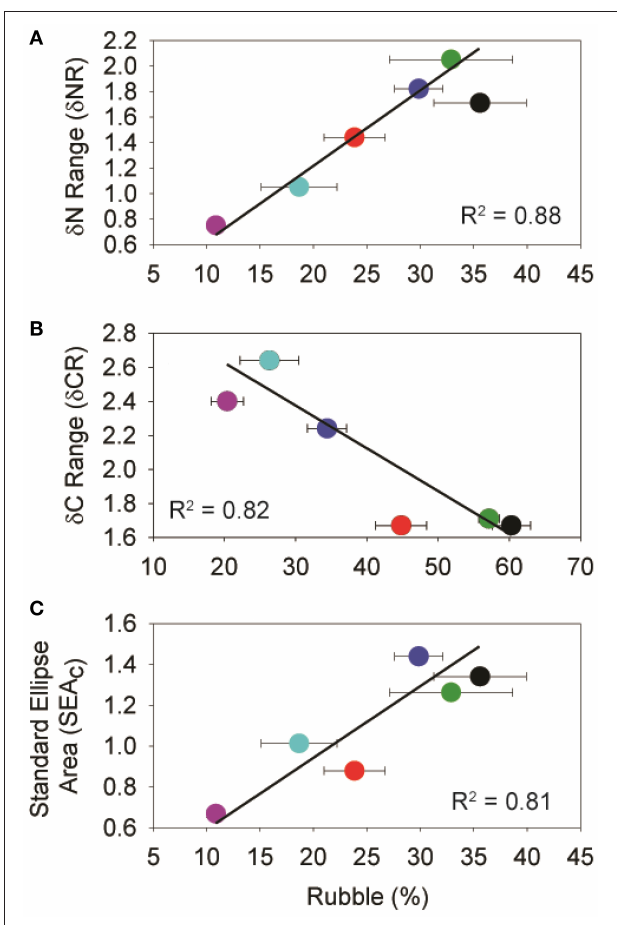
FIGURE 6 | Plots of significant isotopic niche metrics of C. bleekeri vs. mean (% ± SE) rubble cover. Based on the Pearson Product-Moment Correlation Coefficient, all alpha values were between 0.02 and 0.05, with 4 degrees of freedom. Colors represent the different sampling sites and correspond to Figures 1, 5